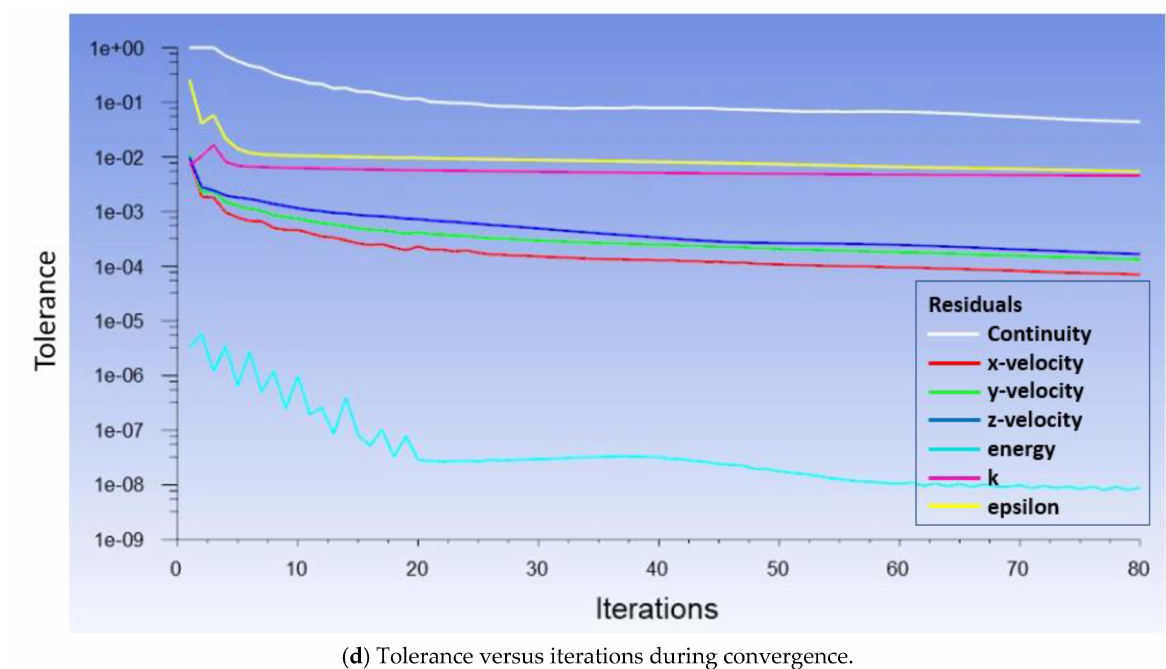
Figure 2. Imaged-based realistic isolated bifurcation airway model: ( a ) surface geometry model and breathing waveform of flow rate for mechanical ventilation (MV) and normal breathing (NB); ( b ) computational mesh. The mesh contains proximately 0.45 million unstructured tetrahedral elements for each bifurcation; ( c ) convergence study through increasing mesh density; and ( d ) tolerance error with iterations plot during